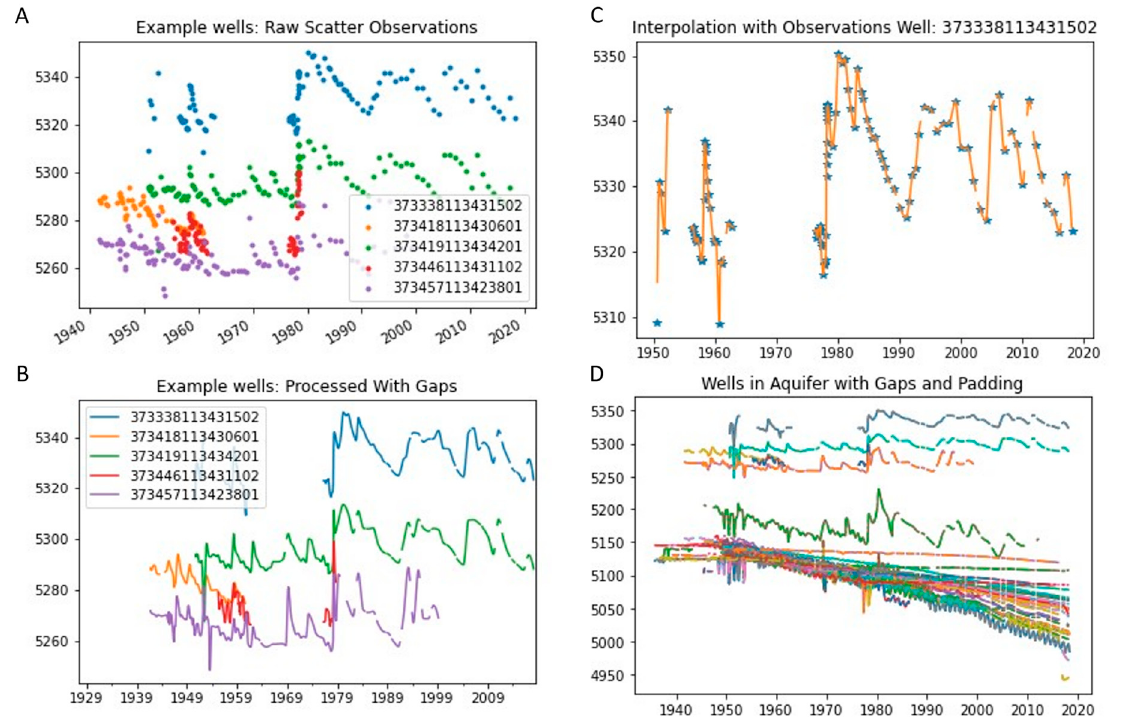
Figure 10. Preprocessed groundwater-surface-elevation data, smoothed and resampled by using PCHIP interpolation: ( A ) the original data; ( B ) five example wells after padding infill and resampling; ( C ) details on a single well, showing the effects of padding; and ( D ) all of the wells in the Beryl-Enterprise aquifer after padding infill and resampling. In these figures the points indicate measurements and the lines interpolated data.